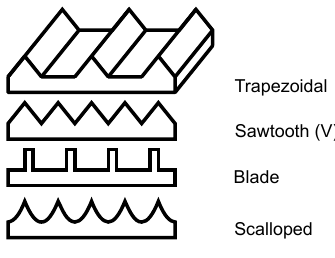
Figure 7. Shapes of